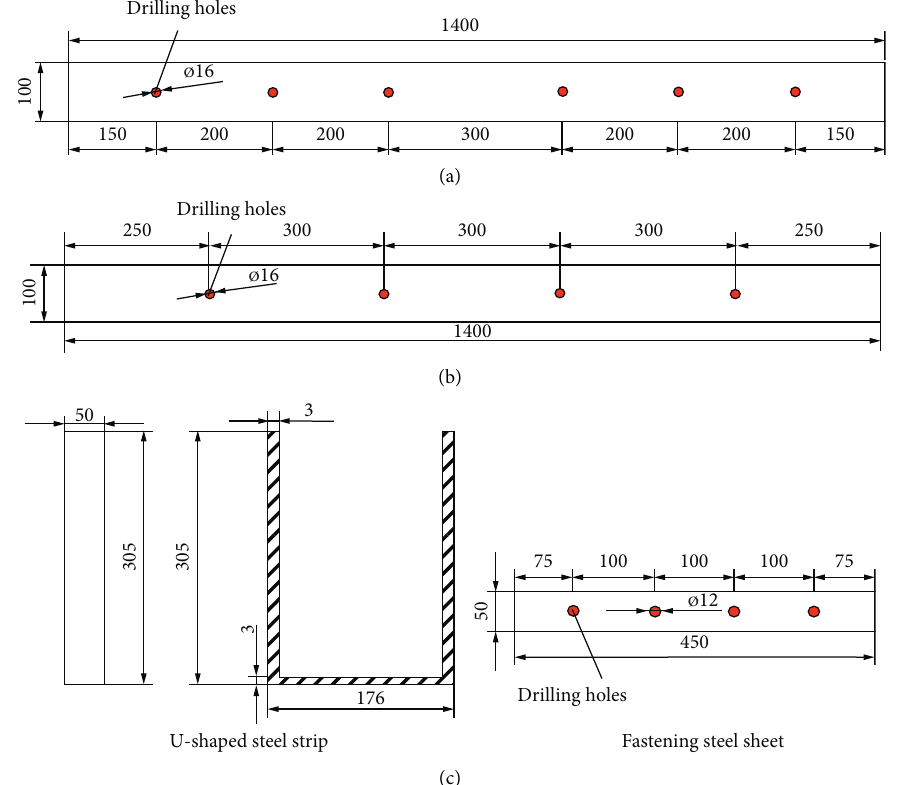
Figure 3: Details of steel plate, U-shaped steel strip, and fastening steel sheet (unit: mm): (a) beam S10C30, (b) beam U10C30, and (c) beam